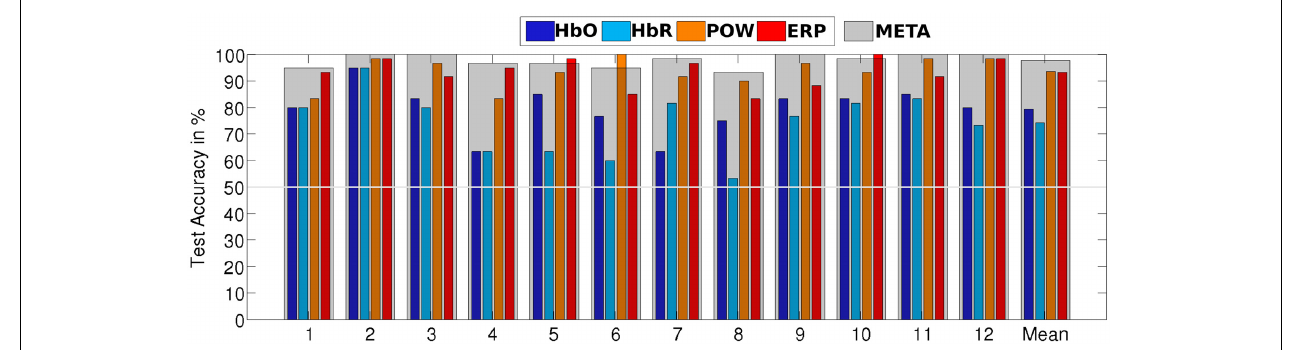
FIGURE 7 | Stimulus-locked recognition rates of AUD vs. VIS for subject-dependent, as well as for subject-independent classification. Recognition rates of the META classifier are indicated by a gray overlay on top of the individual classifiers’ bars.